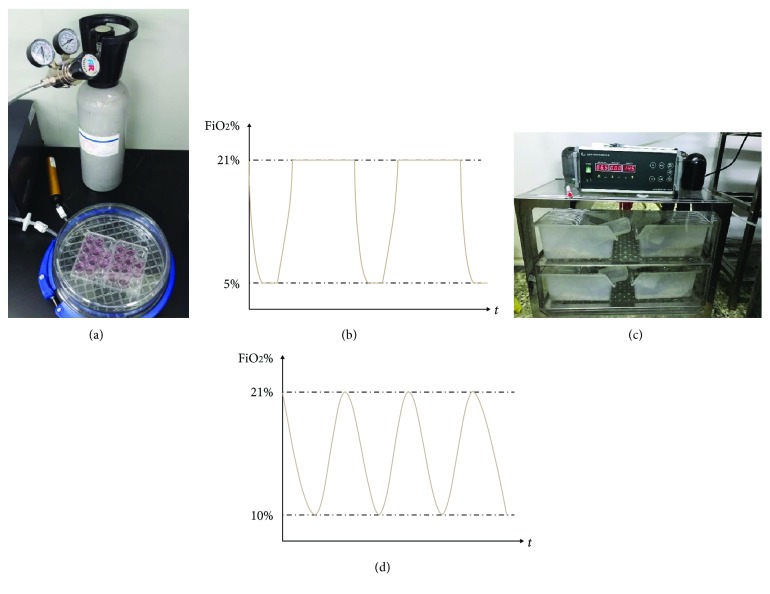
Schematic diagram of IH treatment (in vitro) and CIH treatment (in vivo). (a) Schematic diagram of IH treatment (in vitro); (b) IH treatment cycle pattern (in vitro); (c) schematic diagram of CIH treatment (in vivo); (d) CIH treatment hypoxia cycle pattern (in vivo).